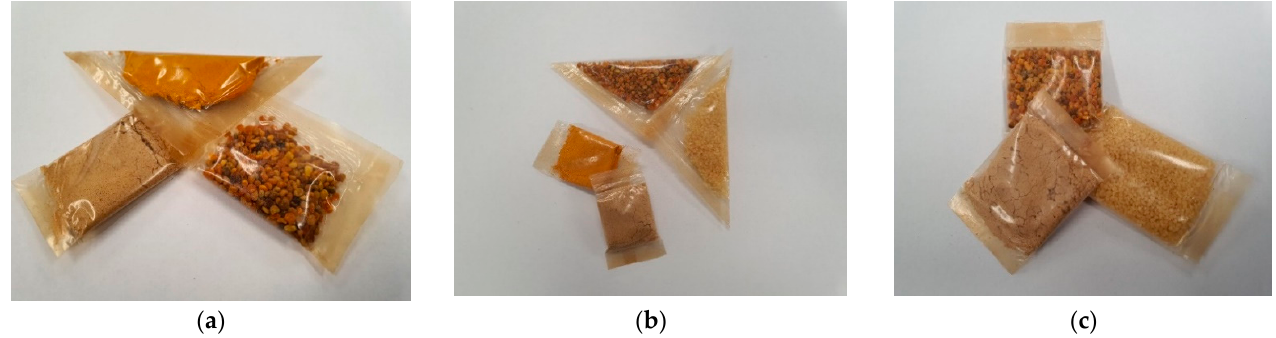
Figure 5. The applications of developed biopolymers-based materials: food supplements (ginger powder, turmeric, pollen, couscous) packed in B14 ( a ), B15 ( b ), and B16 ( c ) films.